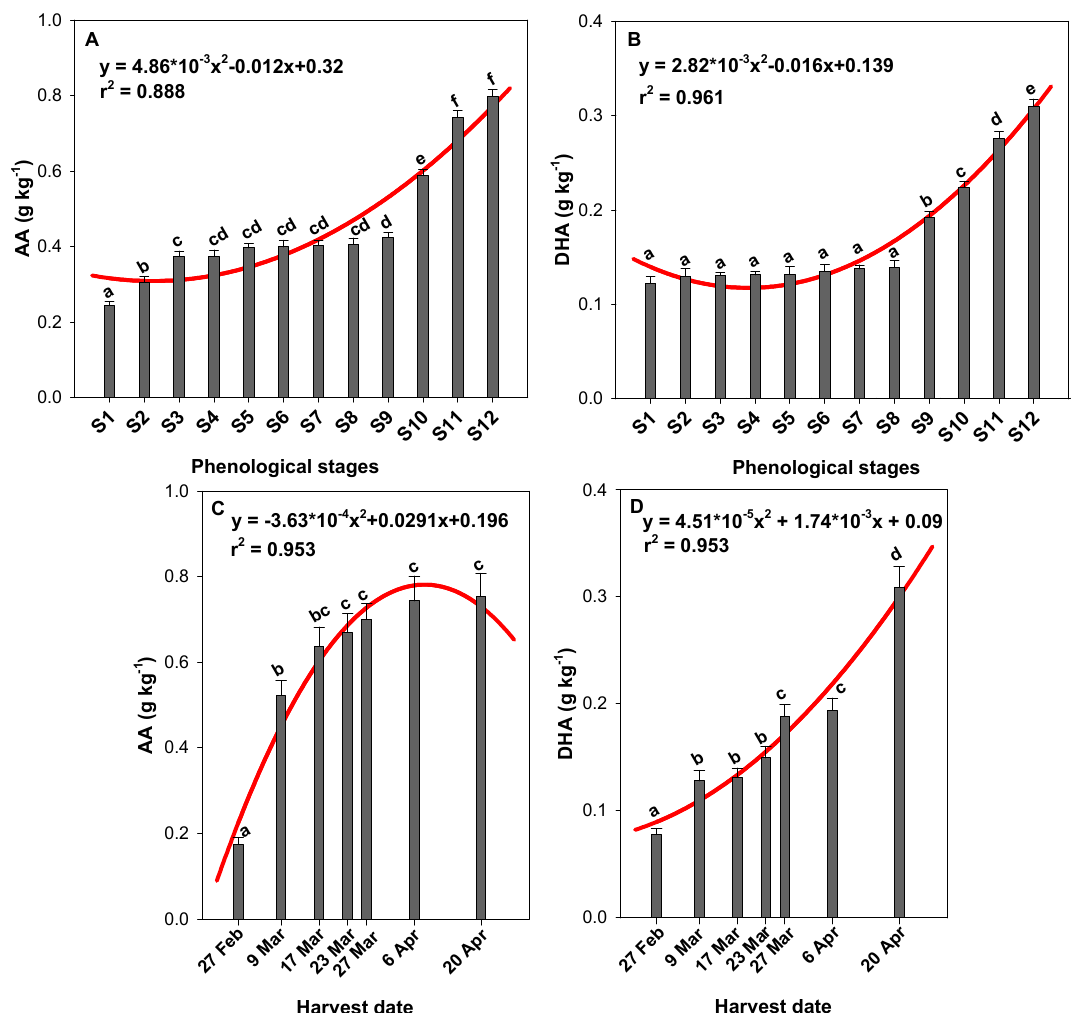
Figure 1. Influence of phenological stages ( A , B ) and harvest date ( C , D ) on ascorbic acid (AA) and dehydroascorbic acid (DHA) content (g kg − 1 ) in green pepper fruit. Lowercase letters show significant differences ( p < 0.05) among phenological stages or harvest dates. A quadratic model regression and its coefficients are shown in each graph.